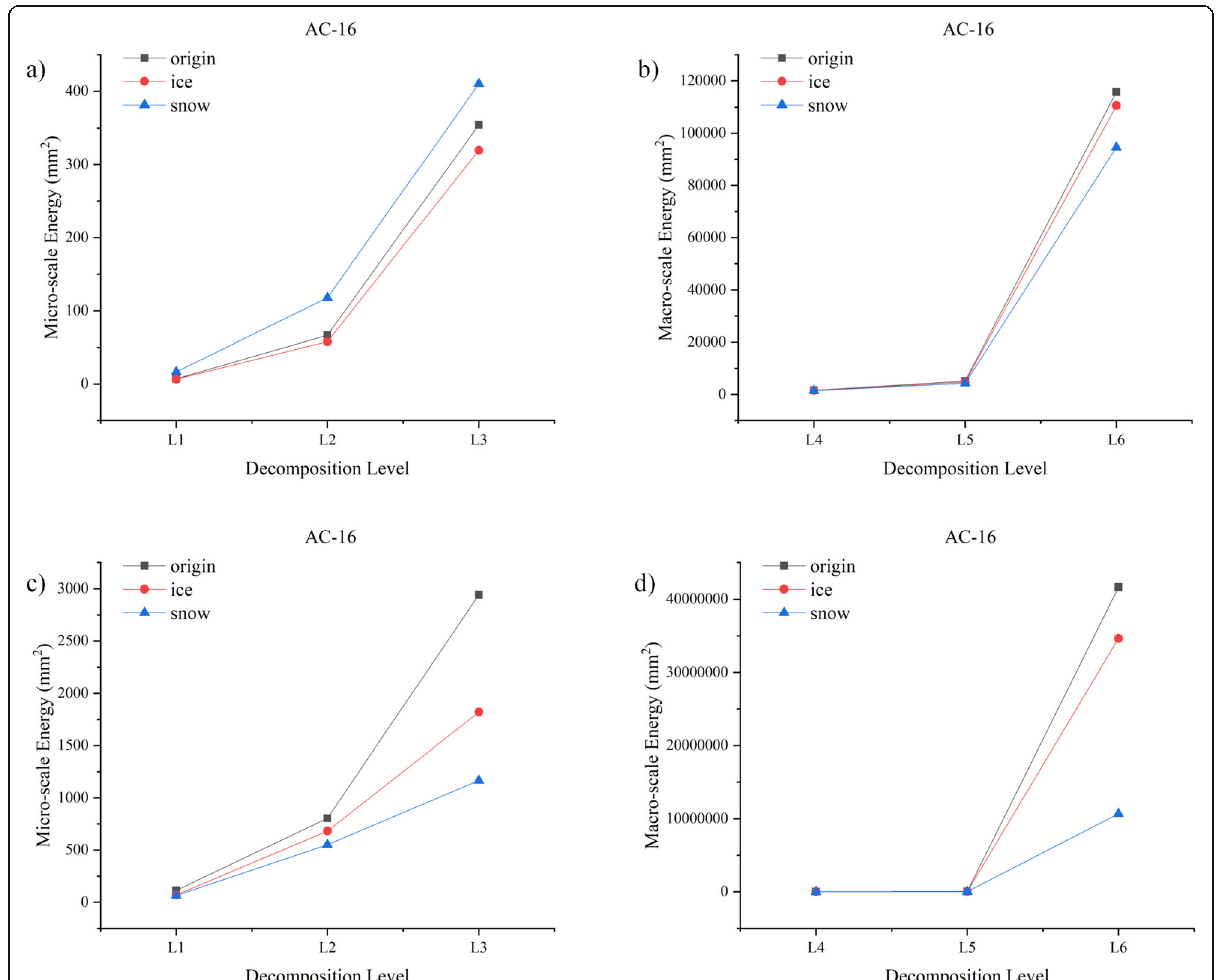
Fig. 9 The Energy Results of AC-16; a 50% Cutting Plane in micro-scale, b 50% Cutting Plane in macro-scale, c 100% Cutting Plane in micro-scale, d 100% Cutting Plane in